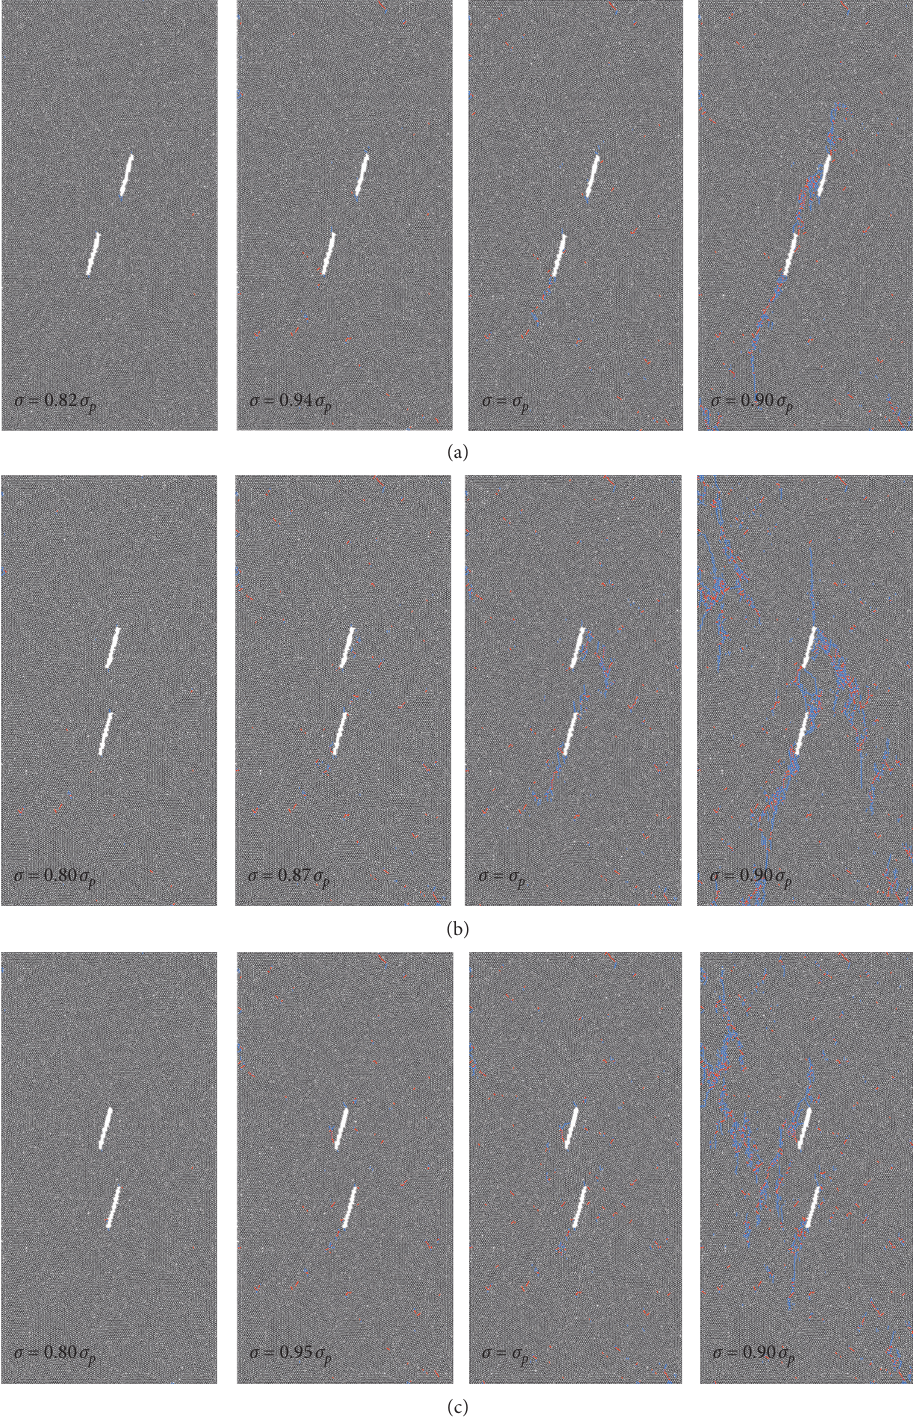
Figure 6: Crack development process of samples containing unfilled flaws with the same α of 75 ° and different β of 60 ° , 90 ° , and 120 ° (blue cracks represent tensile cracks and red cracks represent shear cracks) (a) α � 75 ° and β � 60 ° . (b) α � 75 ° and β � 90 ° . (c) α � 75 ° and β � 120 °